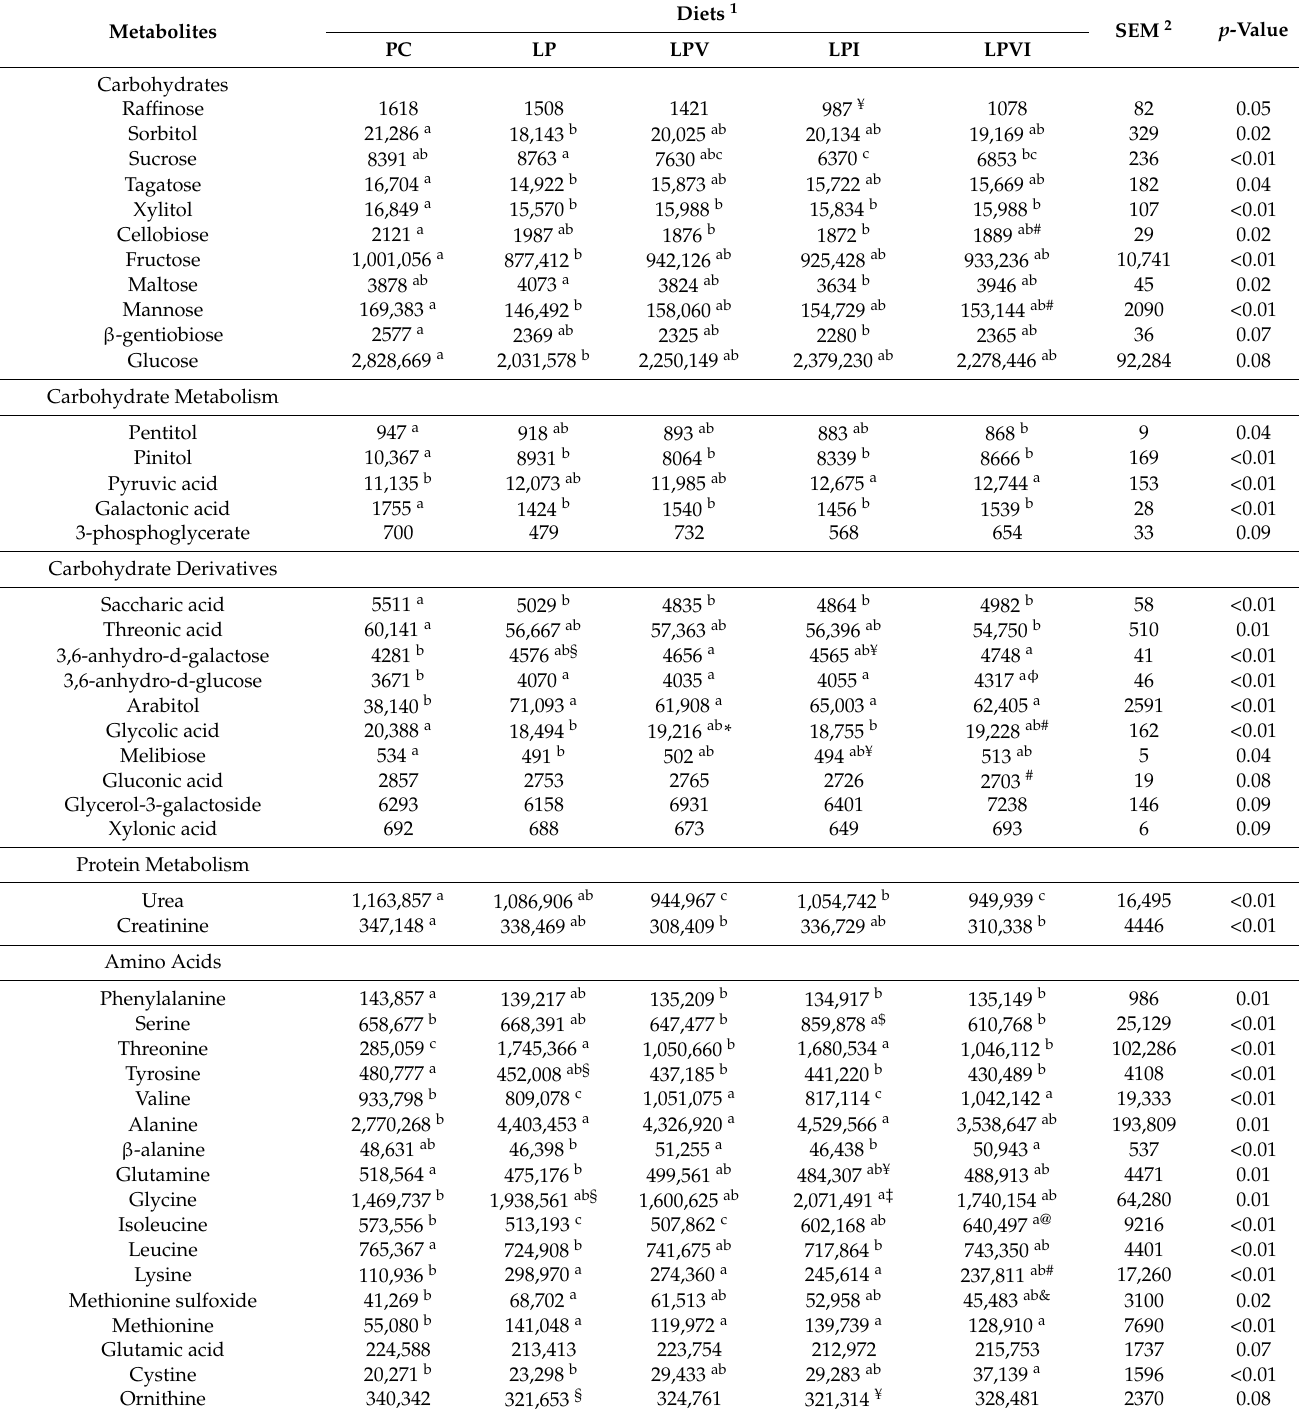
Table 3. Significantly different plasma metabolites in nursery pigs fed with very-low-protein diets supplemented with Ile, Val, or combination of